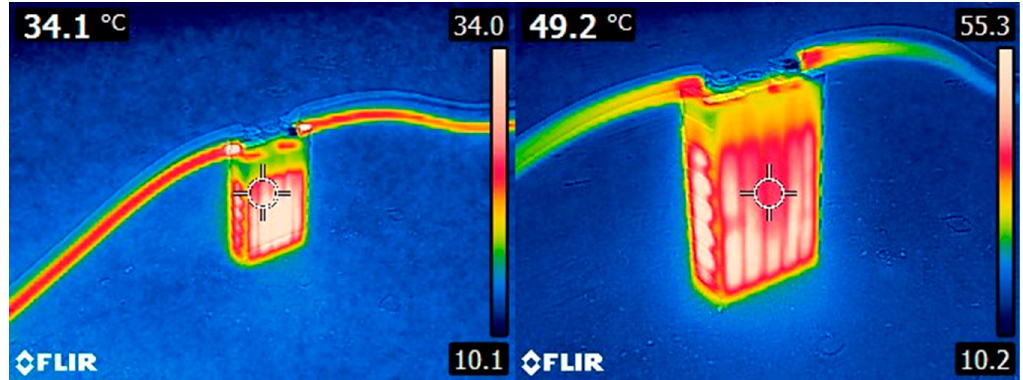
Figure 5. Maximal operational temperature of investigated battery during short-circuit operation.